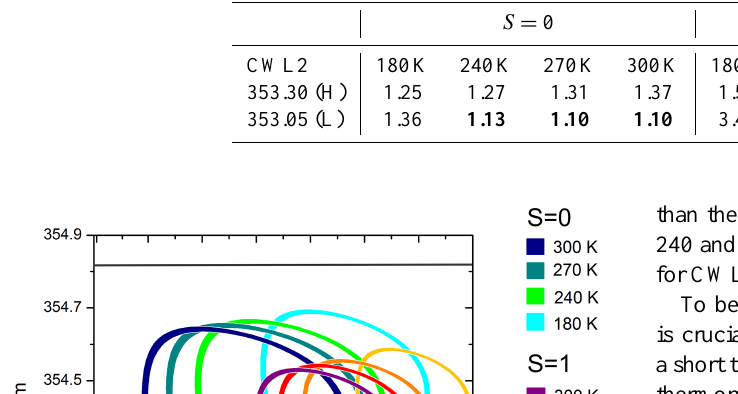
Table 3. Relative statistical temperature error for the high- and low-background setting of the center wavelength CWL2 of the interference filter of the second (high J ) rotational Raman channel (H and L, respectively). S is the scaling factor for the background level (see text for details). While S = 0 stands for no background, S = 1 characterizes high-background conditions. The resulting relative errors for the selected configurations are bold. With the optimized settings for CWL2 the statistical errors do not exceed 20% higher values than the absolute optimum for atmospheric temperatures between 240 and 300K.